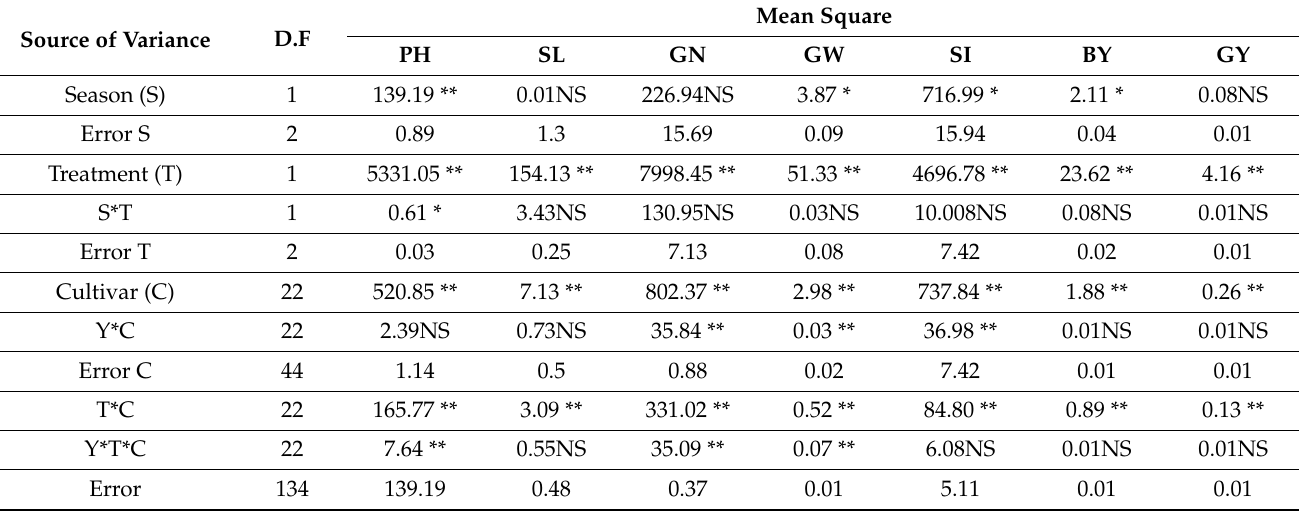
Table 4. Analysis of variance and mean square of all studied